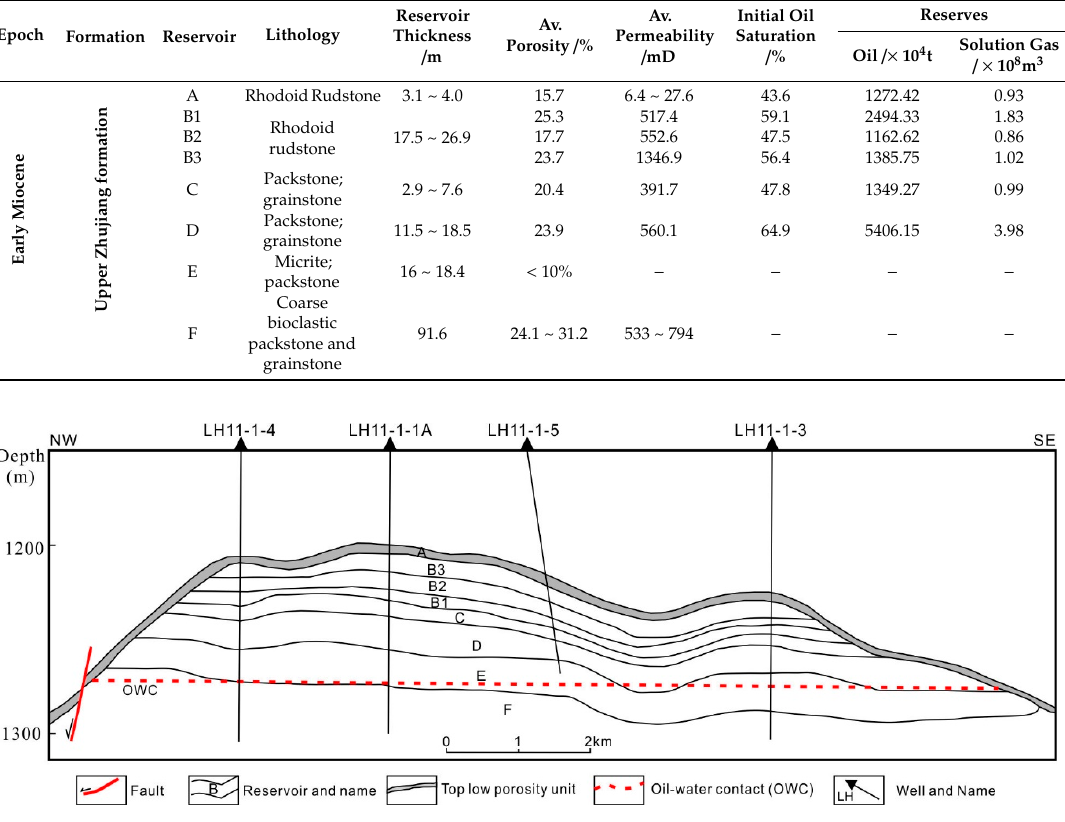
Figure 2. Simplified NW to SE geological cross section across the LH11-1 reef limestone oilfield (Modified according to Liu et al., 2015 [22]). Table 1. Reservoir characteristics of the LH oilfield [17,22].